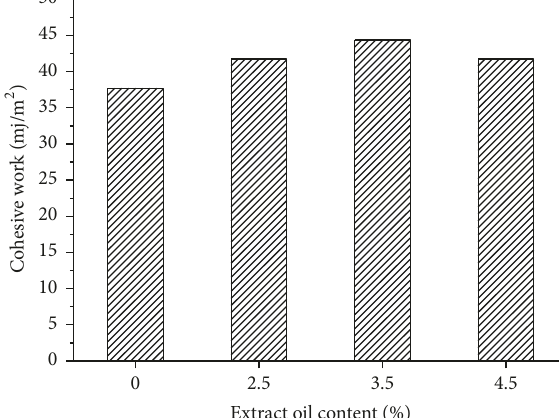
Figure 8: The cohesive work versus SBS content of SBS-modified asphalts. Figure 9: The cohesive work versus furfural extraction oil contents of SBS-modified asphalts.